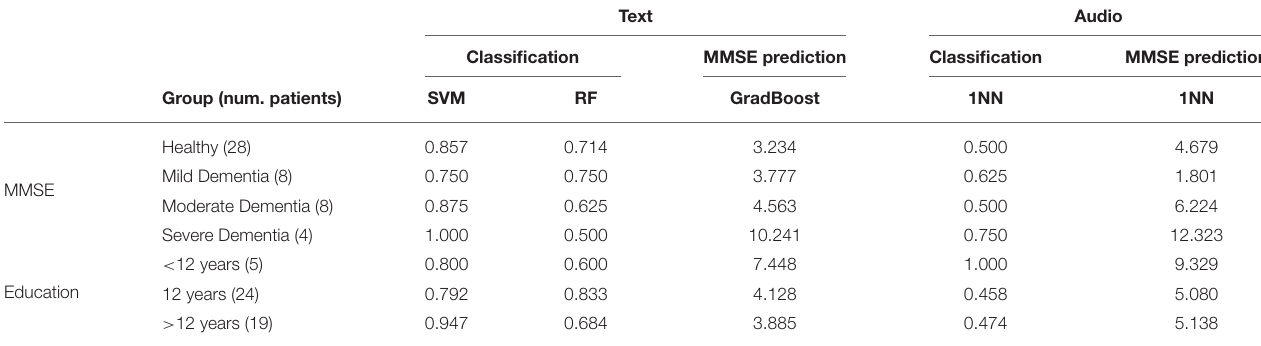
TABLE 7 | Test set accuracies and RMSE scores for different levels of cognitive deficiency and